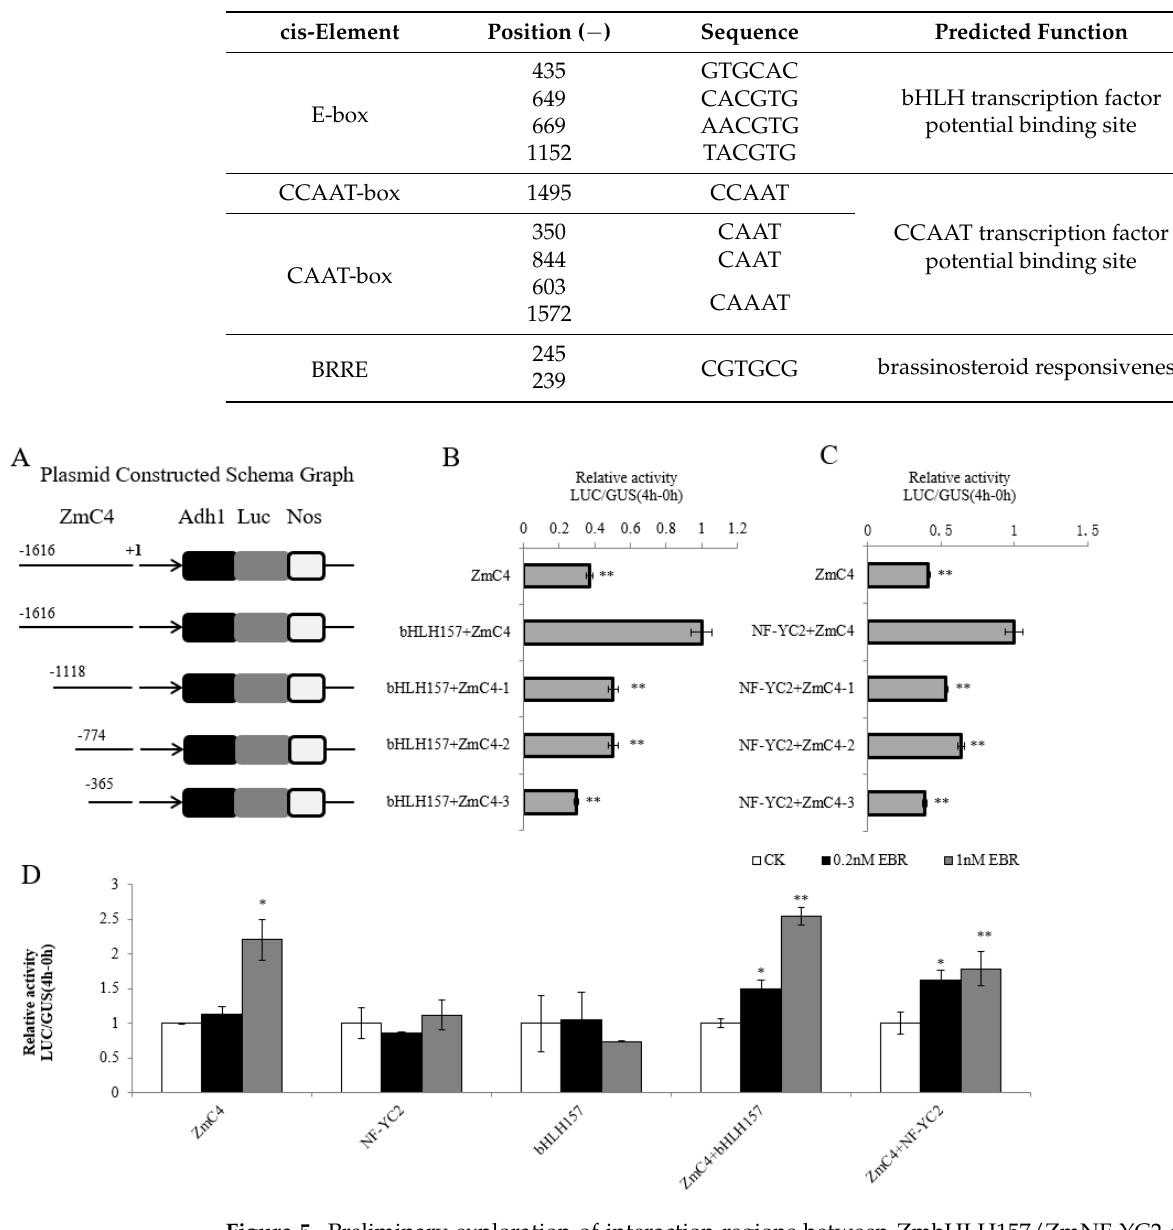
Table 1. Prediction of cis-acting elements of ZmC4 NADP-ME promoter.